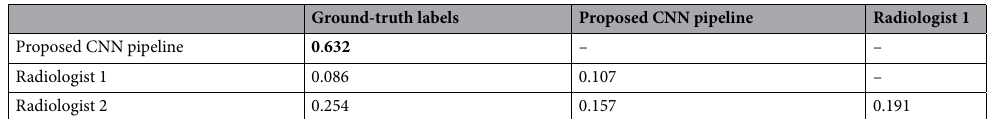
Table 3. Cohen’s Kappa Agreement between the proposed CNN pipeline, radiologists, and ground truth labels. The bold element indicates the highest agreement between